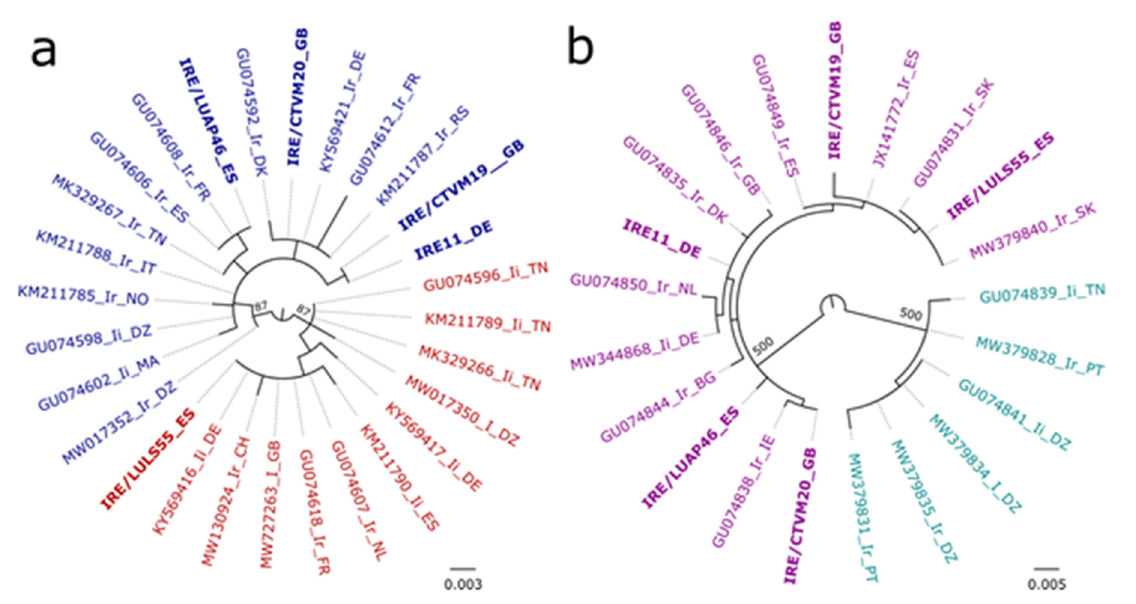
Figure 4. Maximum likelihood phylogenies of 16s rRNA and trospA gene fragments amplified from the Ixodes ricinus cell lines IRE/LUAP46, IRE/LULS55, IRE/CTVM19, IRE/CTVM20 and IRE11. ( a ) 16s rRNA (441 nucleotide positions): sequences in the 184-AG haplogroup shown in red and sequences in 184-CT haplogroup shown in blue. ( b ) trospA (695 nucleotide positions): sequences from North Africa and Portugal shown in turquoise and sequences from Europe, excluding central and southern Portugal, shown in purple. Sequences generated from the I. ricinus cell lines are in bold. Sequences obtained from NCBI GenBank are represented by the accession numbers and followed by the country codes. Ir = I. ricinus , Ii = Ixodes inopinatus , I = Ixodes sp. Bootstrap support values greater than 70% are shown adjacent to the nodes. Scale bars represent the number of substitutions per site.